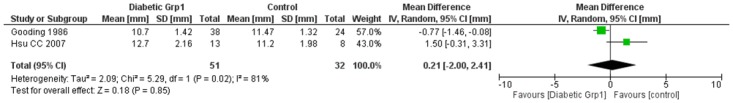
Meta-analysis and forest plot for sub-metatarsal head 5 unloaded total soft tissue depth, non-diabetic and diabetic group 1.